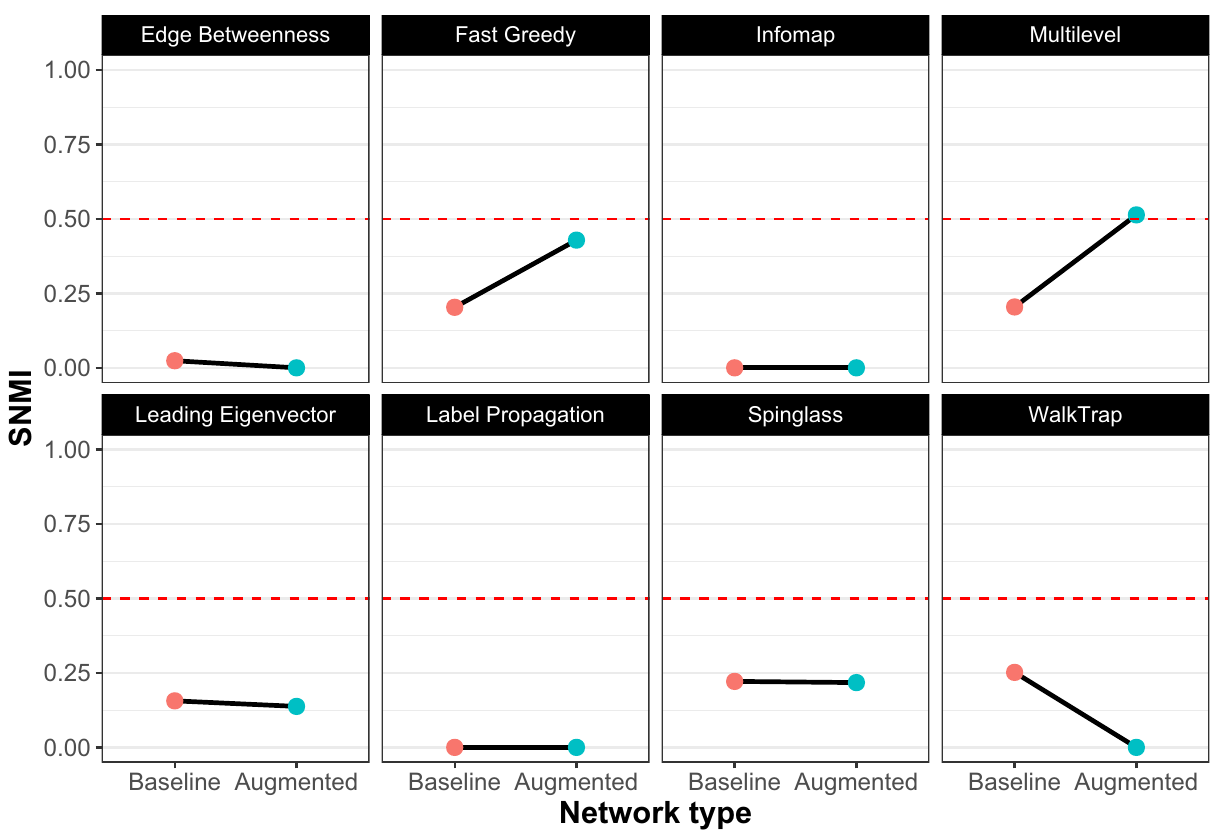
Figure 6. The performances of the 8 community detection algorithms are shown on the “baseline” (pink) and “augmented” (cyan) empirical network. The y-axis tracks the scaled Normalized Mutual Information (SNMI) value for each algorithm. As with the synthetic networks, Fast Greedy, Multilevel, and Spin-Glass outperform the others on the “baseline” network. The performances of FG and ML are yet again, further enhanced with the augmented network, while as before that of WT is lowered. Overall, and as before, it is FG and ML on the augmented network, that perform the